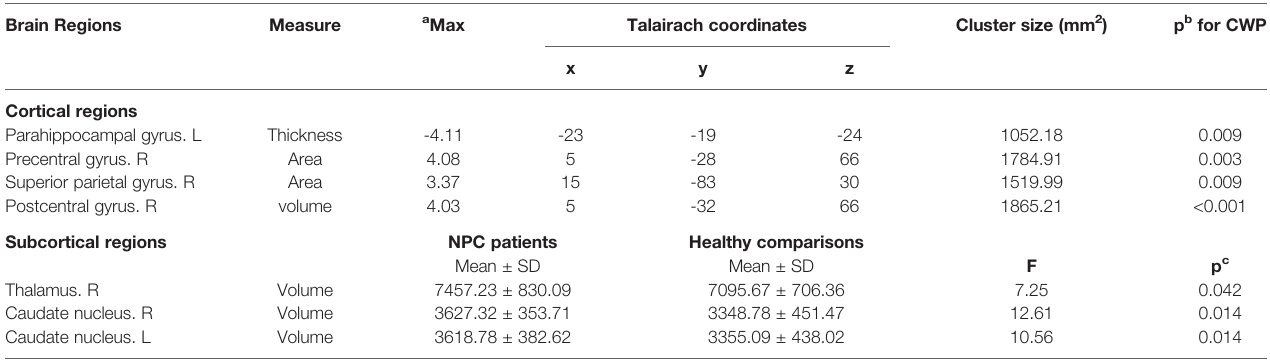
TABLE 2 | Regional gray matter differences in cortical thickness, surface area, gray matter volume between patients with nasopharyngeal carcinoma and healthy comparisons.